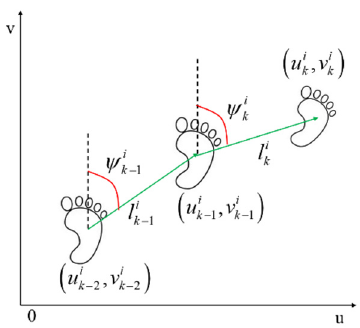
Figure 2. Schematic diagram of the pedestrian motion trace update.